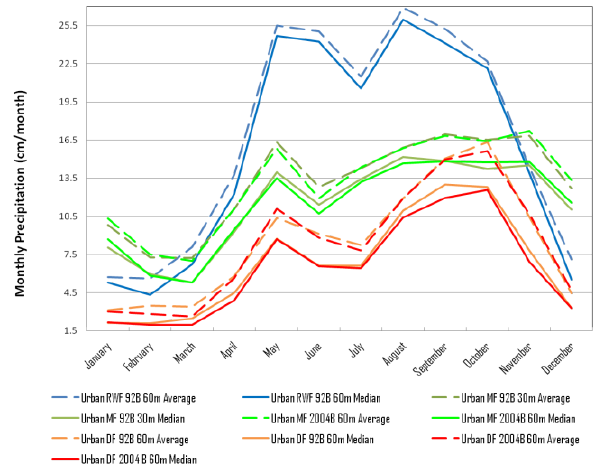
Figure 6. Average and median monthly precipitation for urban stations by HELZ.